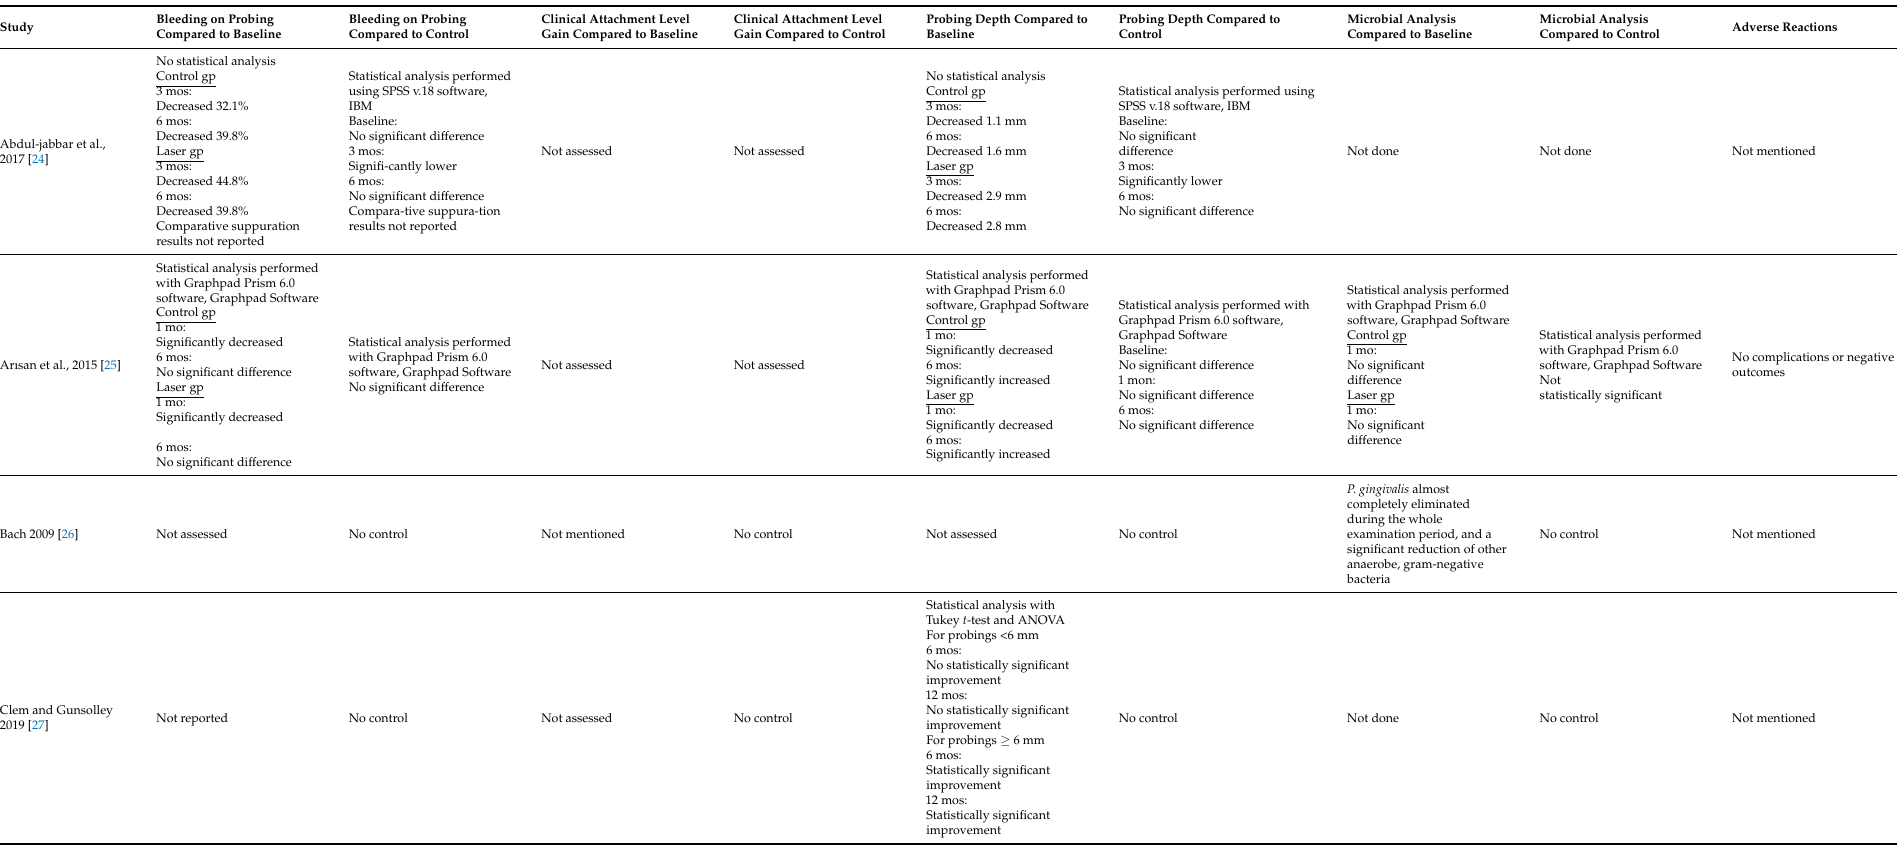
Table 7. Other clinical parameters and outcomes.